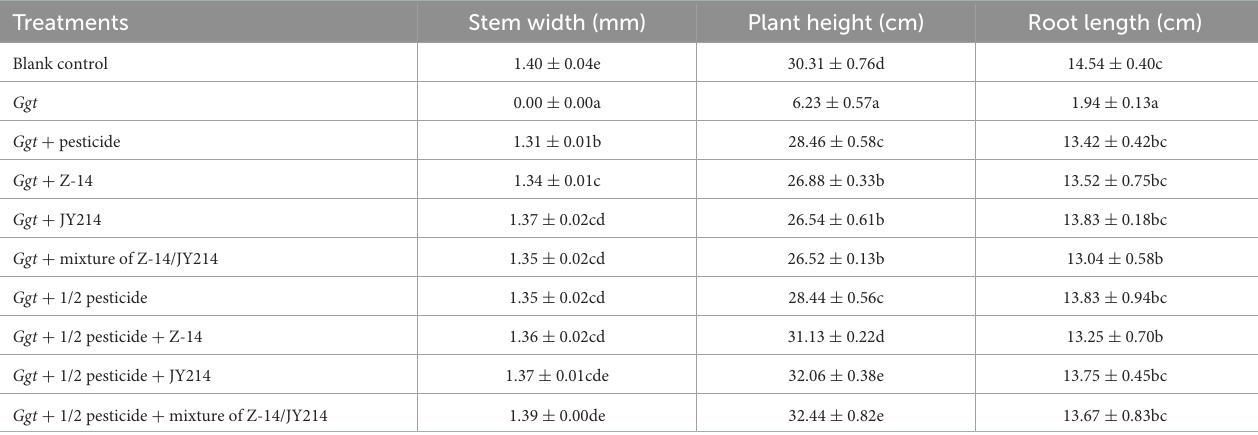
TABLE 4 Effects of pesticide, Z-14, JY214, and their combinations on root length, root fresh weight, and aboveground weight of Ggt -infected wheat in the greenhouse experiments.